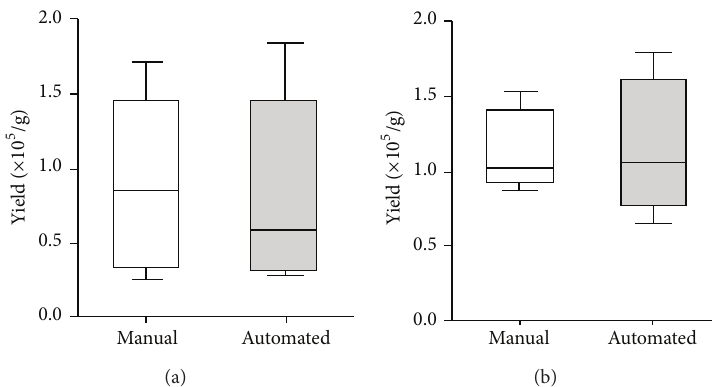
Figure 4: Comparison of SVF yield from manual and automated process. Yield of SVF obtained by automated digestion (a) and filtration (b) as compared to the manual process of cell isolation using centrifugation technology. Data is represented as mean ± SD for four individual samples tested. Difference in cell yield between manual centrifugation method and automated filtration is not significant ( 𝑝 = 0.8 , paired 𝑡 -test). Table 4: Yield and viability of SVF obtained by the automated process using filtration technology as compared to the manual process of cell isolation using centrifugation. Digestion Filtration Manual Automated Manual Automated